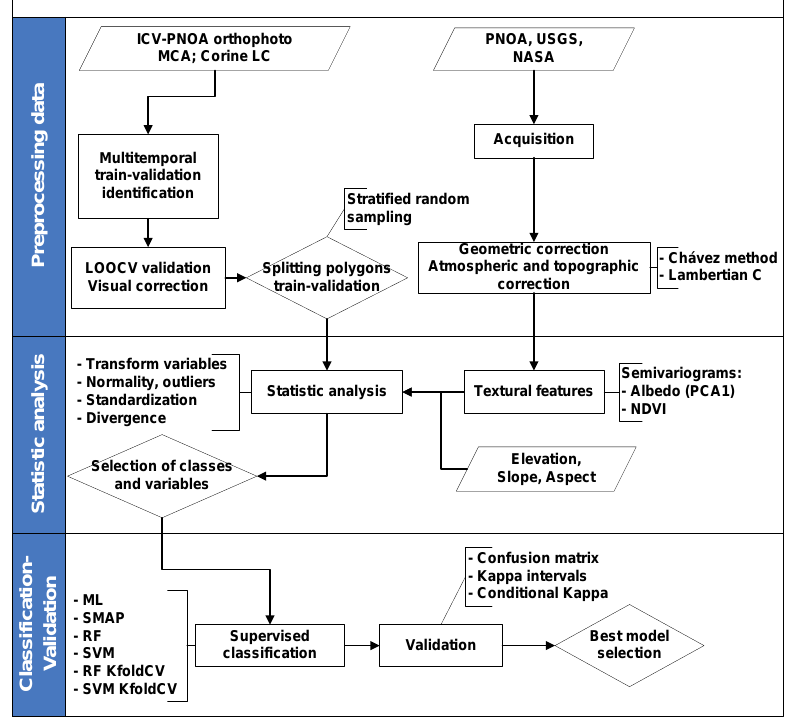
Figure 2. Methodological flowchart. SMAP, Sequential Maximum A Posteriori; ICV, Cartographic Institute of Valencia; PNOA, Spanish Orthophotography National